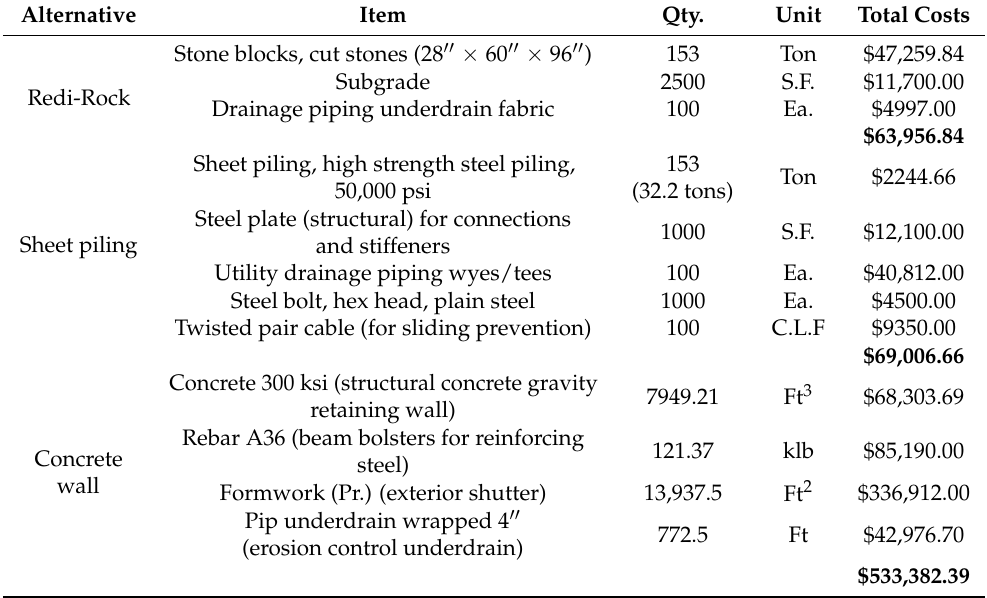
Table A2. The estimated costs for the construction of the retaining wall